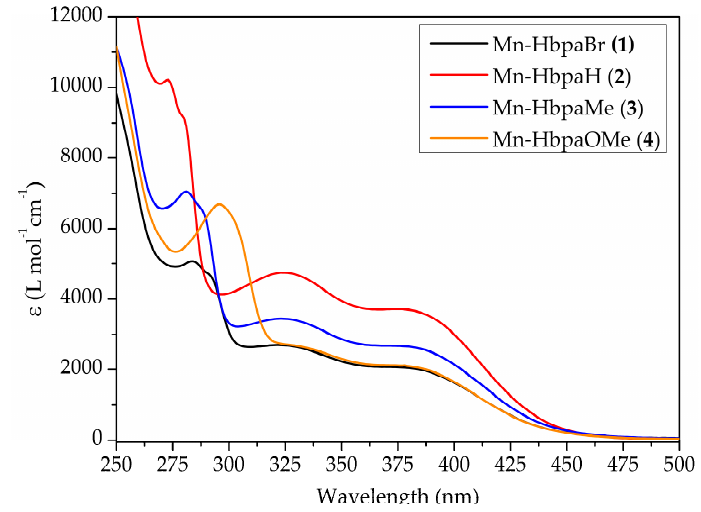
Figure 4. Electronic spectra of compounds ( 1 )–( 4 ) in dichloromethane. ( 1 ) = 1.513 × 10 − 4 mol L − 1 ; ( 2 ) = 1.579 × 10 − 4 mol L − 1 ; ( 3 ) = 1.592 × 10 − 4 mol L − 1 ; ( 4 ) = 1.560 × 10 − 4 mol L − 1 .